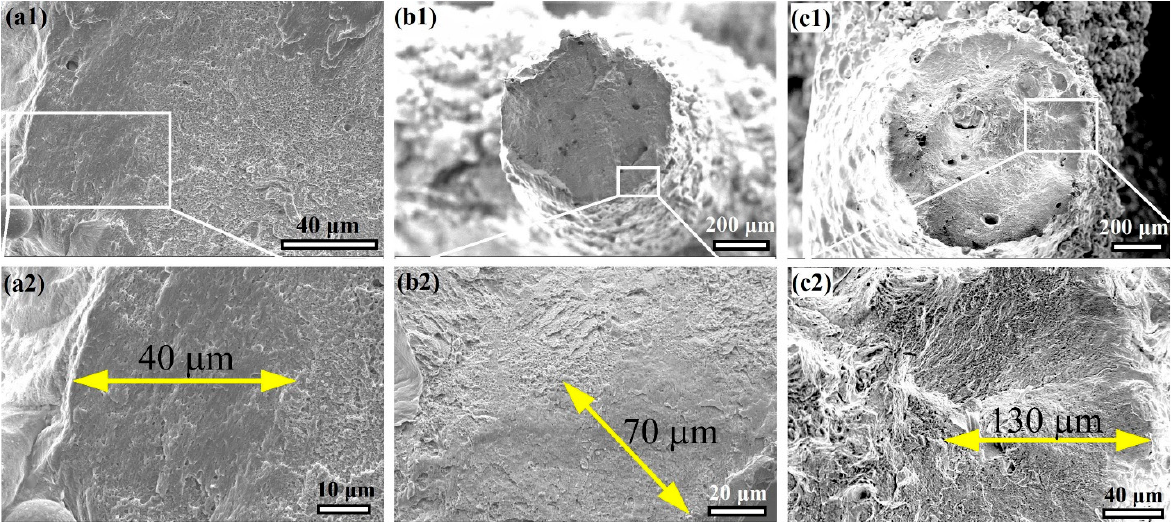
Figure 6. The fracture surfaces of the H-charged specimens. SEM images of ( a ) T0.6, ( b ) T1, and ( c ) T1.4 after tensile testing. The magni fi cation views in ( a2 ), ( b2 ), and ( c2 ) are selected as indicated by the white rectangles in ( a1 ), ( b1 ), and ( c1 ). The yellow arrows refer to the depth of the cleavage facets beneath the edges of the specimens.